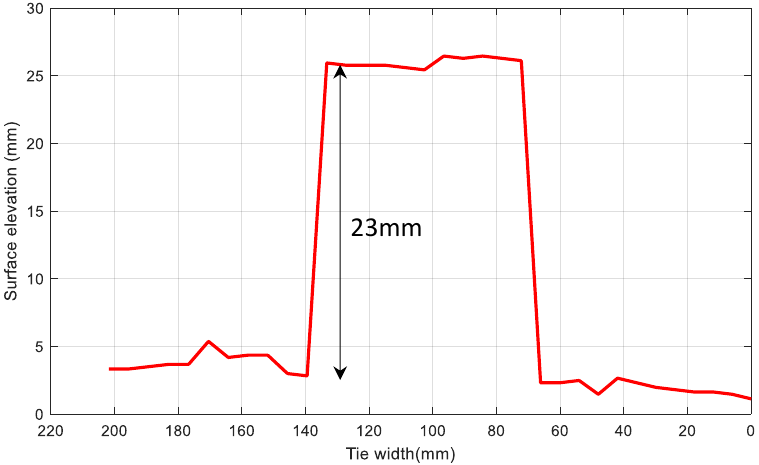
Figure 19. Tie width profile at transducer location 1 ( Ch 1) for a control tie with a wood